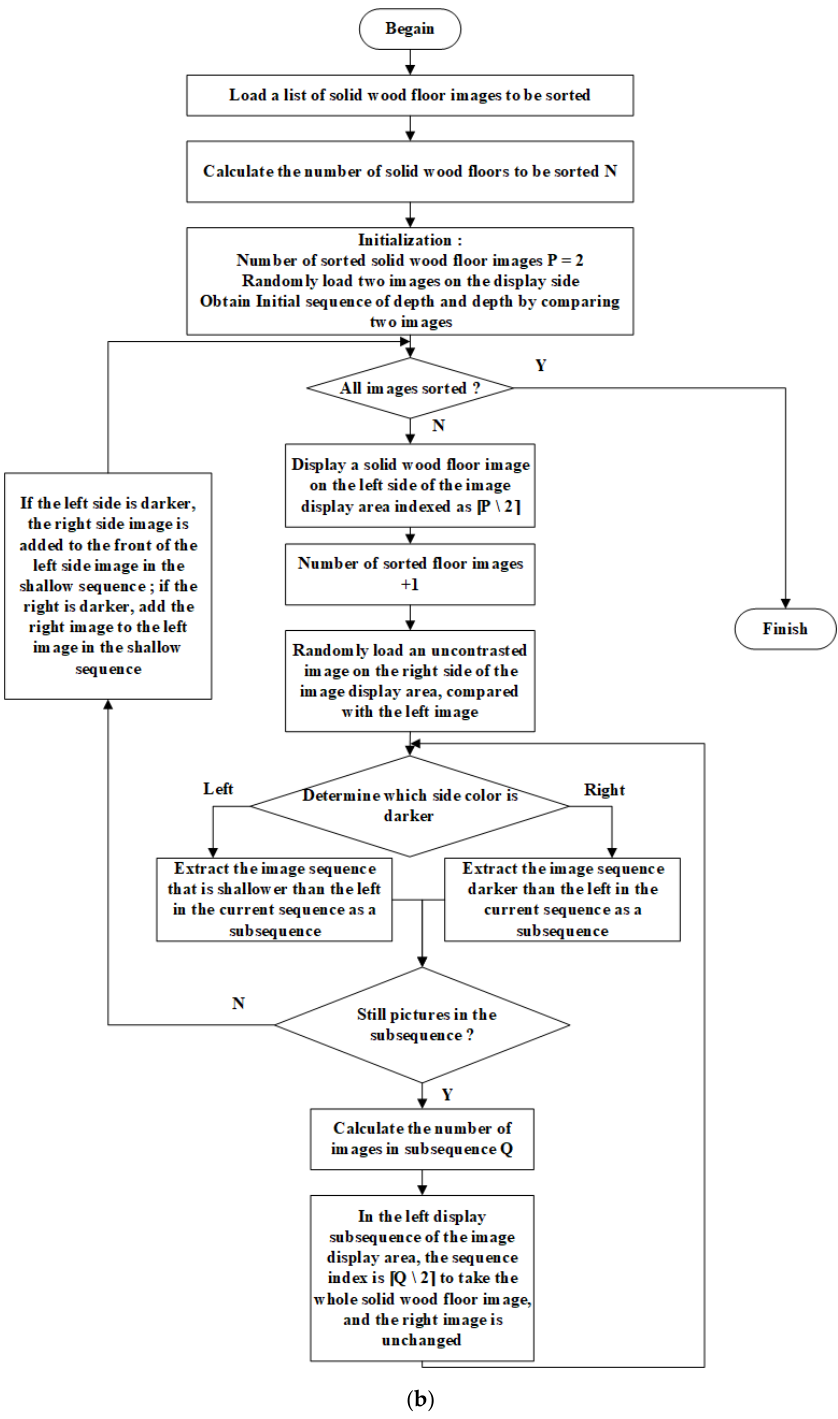
Figure 4. Artificial datasets. ( a ) Sorting software interface diagram. ( b ) Flow chart of manual sorting. The time-complexity of the artificial color sorting algorithm used was O (nlogn), which means it is a fast-sorting algorithm and this reduces the work of artificial sorting. At the same time, since the company provided the color categories of the solid wood floors, the algorithm can sort according to the color category first, and then sort within the given color category, which further reduces the work involved in artificial sorting. In order to verify the robustness of the algorithm, 98 solid wood floor images were randomly selected for